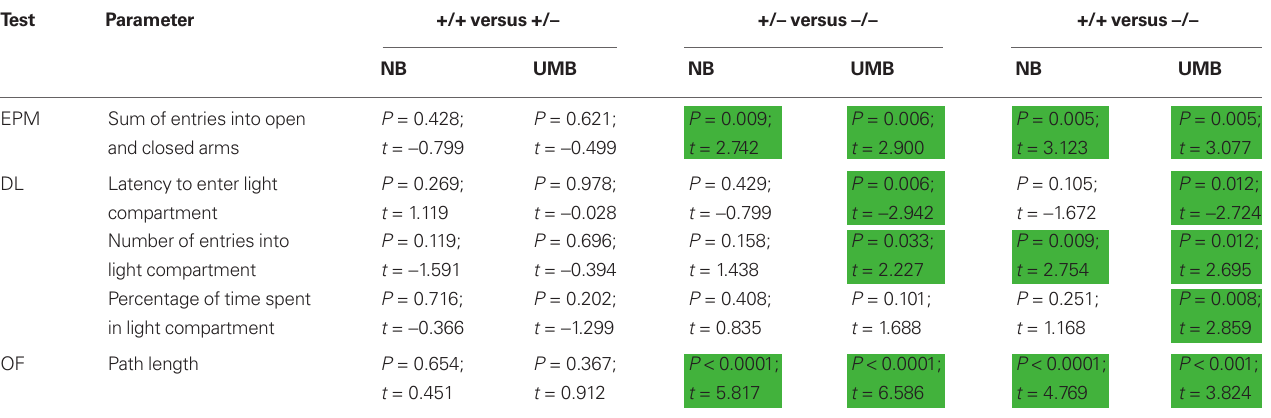
Table 3 | Pairwise comparisons between genotype groups. Direction of signifi cant differences see